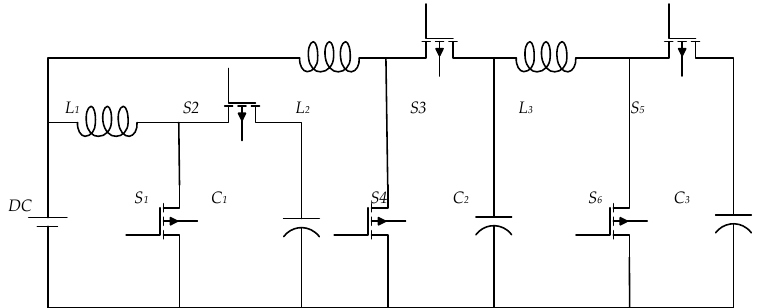
Figure 7. Dual output converter after synthesis.